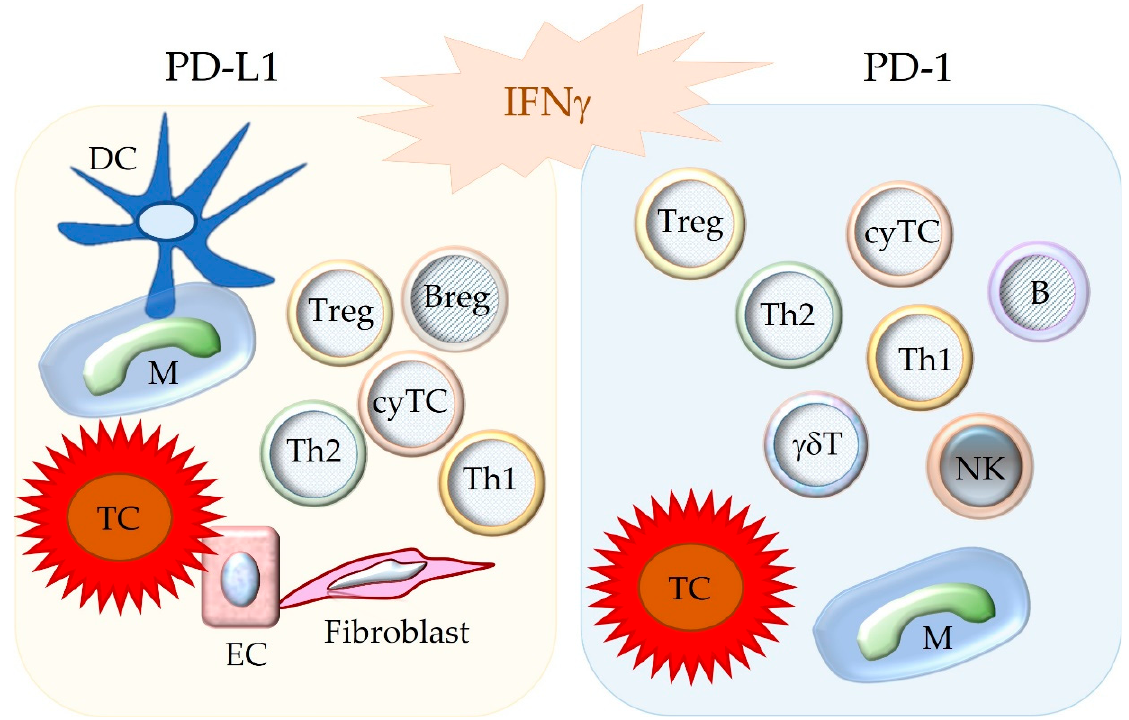
Figure 2. Depicted are cell populations with possible expression of the immune checkpoint molecules PD-L1 and PD-1. Notably, these molecules are upregulated by IFN γ . The binding between PD-L1 and PD-1 inhibits the functions of the PD-1-bearing target cell. DC = dendritic cell; M = macrophage; TC = tumor cell; EC = endothelial cell; Treg = regulatory T cell; Breg = regulatory B cell; B = B cell, Th1 = T helper 1 cell; Th2 = T helper 2 cell; cyTC = cytotoxic T cell; NK = natural killer cell; γδ T = γδ T cell.